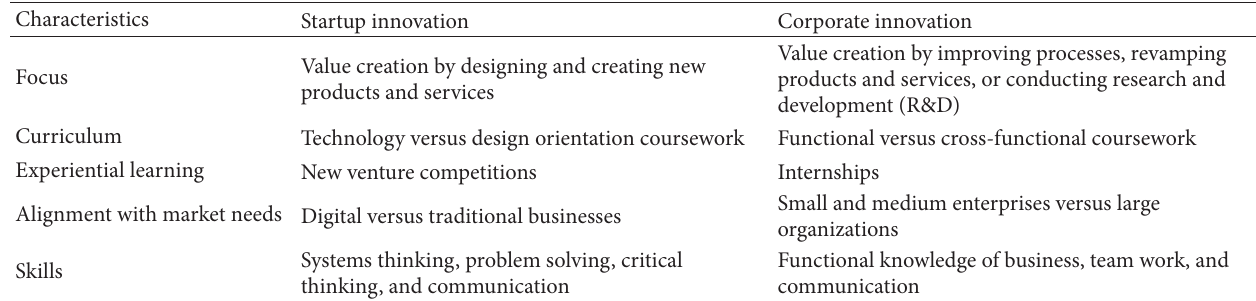
Table 1: Characteristics of entrepreneurship